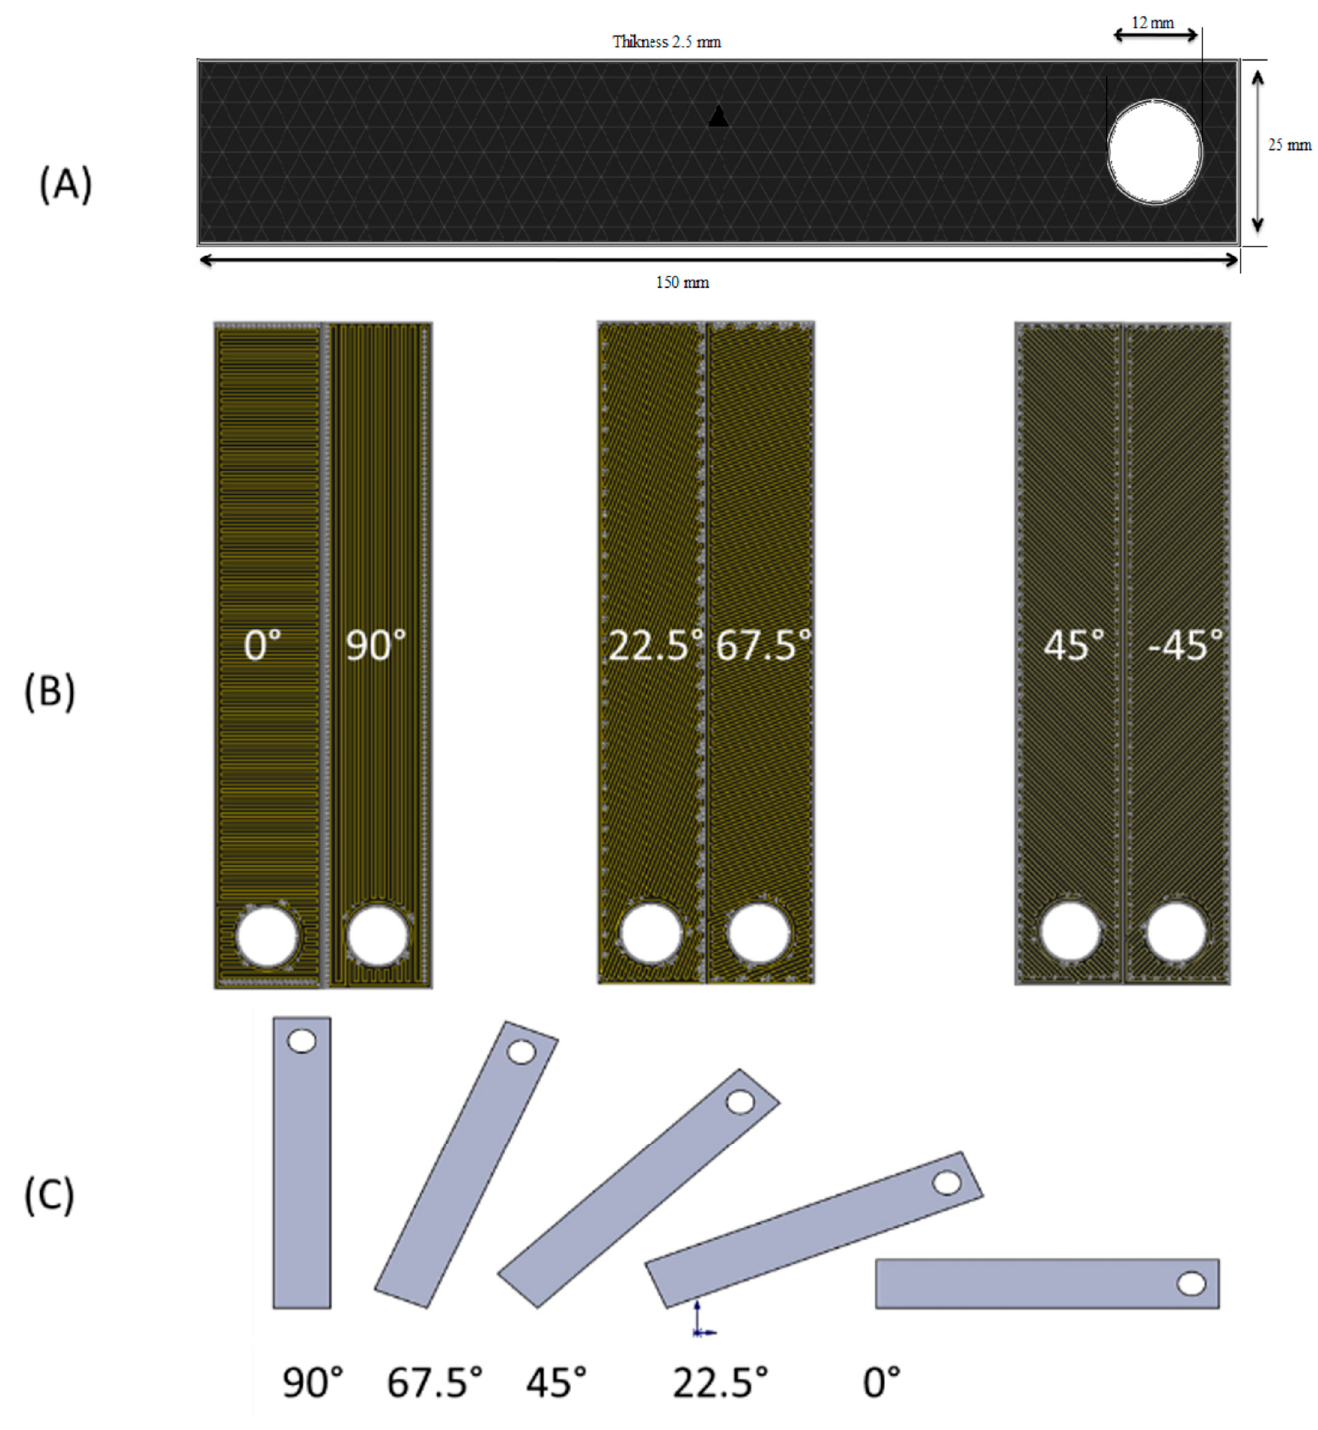
Figure 2. ( A ) The 3D-printed, fiber-reinforced structure, ( B ) different fiber orientation configurations, and ( C ) CAD geometry according to different fiber orientation configurations.